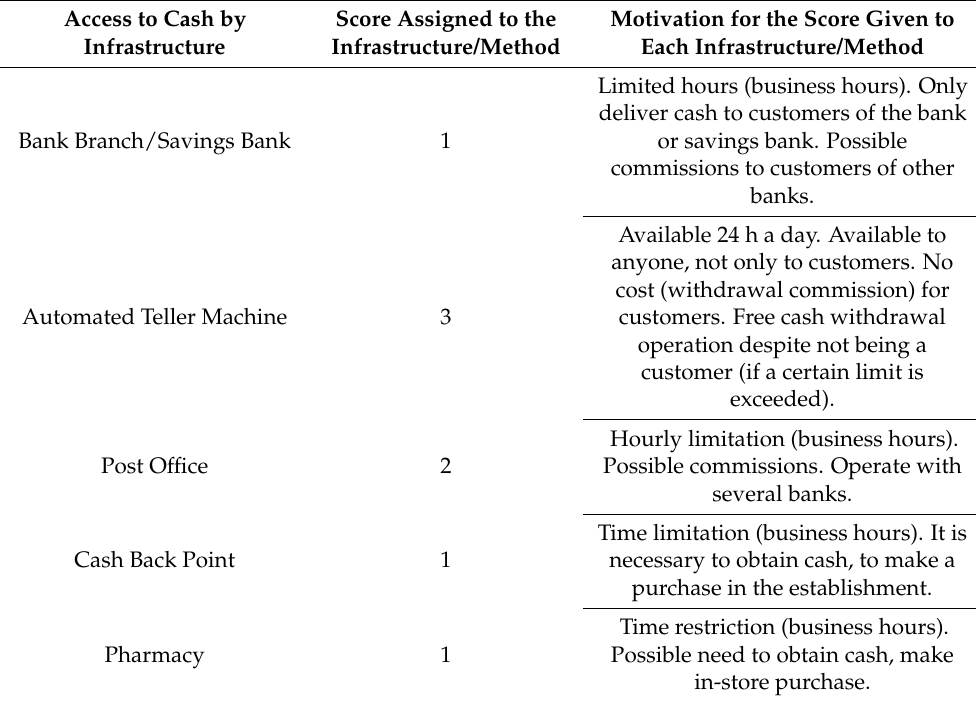
Table 1. Method of access to cash and score given in calculation of the Cash Access Index. Access to Cash by Score Assigned to the Motivation for the Score Given to Infrastructure Infrastructure/Method Each Infrastructure/Method Limited hours (business hours). Only deliver cash to customers of the bank or savings bank. Possible commissions to customers of other